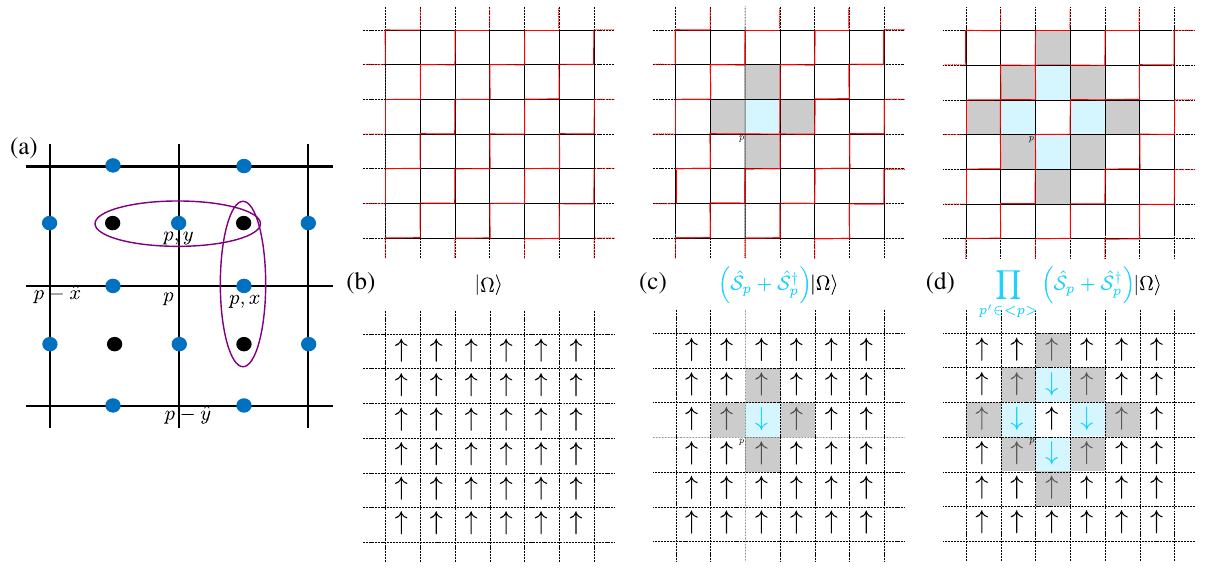
FIG. 2. Graphical illustration of the duality. (a) Definition of the link spins (blue dots) in terms of the dual plaquette spins (black dots), as in Eq. (5). The dual spins live in the dual lattice formed by the centers of the plaquettes. The value of the link spin is determined by the plaquette spins of the two plaquettes sharing the link, as indicated by the purple ellipses for the links p , x and p , y . The orientation of the plaquette spins is chosen such that the fully flippable state j Ω i is mapped in the dual basis into the ferromagnetic state (b). (b) – (d) We represent the configurations that are relevant to understand the generalized blockade condition simultaneously in the original (above) and the dual (below) basis. In the former, we represent the link spins with the color convention in Fig. 1. In the latter, we represent the dual plaquette spins as arrows placed in the center of the corresponding plaquettes. (b) The reference state j Ω i : We identify it with the ferromagnetic state with all plaquette spins up. (c) After flipping one plaquette of j Ω i , all the neighboring plaquettes are blocked. (d) After flipping all its neighboring plaquettes, the plaquette p is